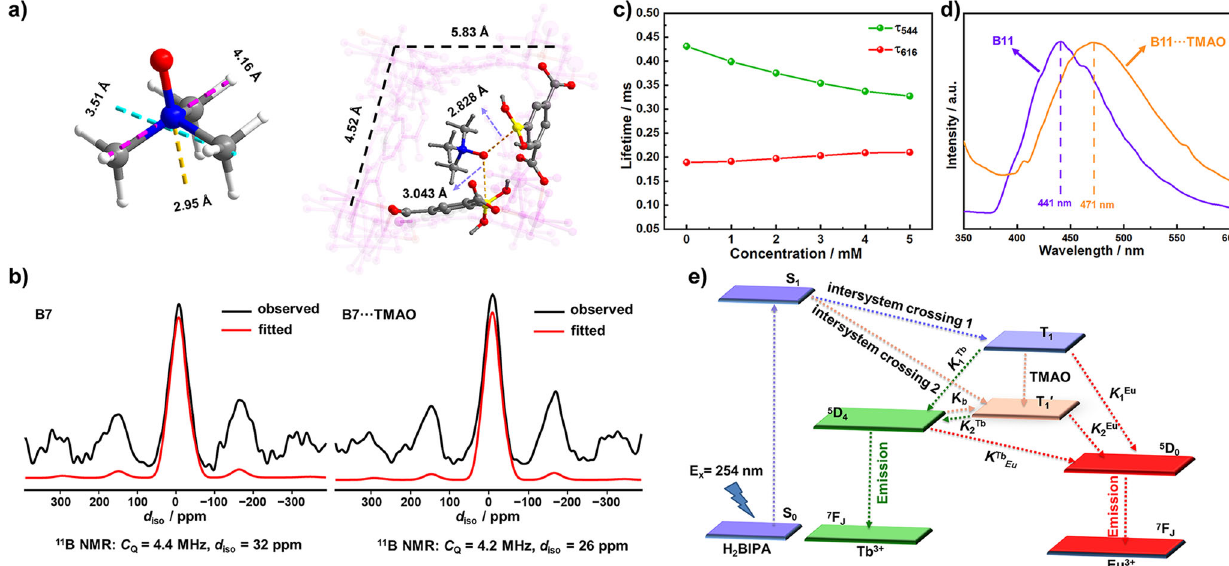
Fig. 4 Direct interaction between B7 and TMAO. a Molecular size of TMAO and the interaction between TMAO and B7 . b Solid-state MAS 11 B NMR spectra of B7 before and after treated by 100 mM TMAO for 24 h. c Fluorescent lifetimes at 616 nm (red) and 544 nm (green) of B7 suspension at different concentrations of TMAO. d Emission spectra of B11 and B11 ‧‧‧ TMAO at 77 K. e Energy transfer pathways for sensing TMAO by B7